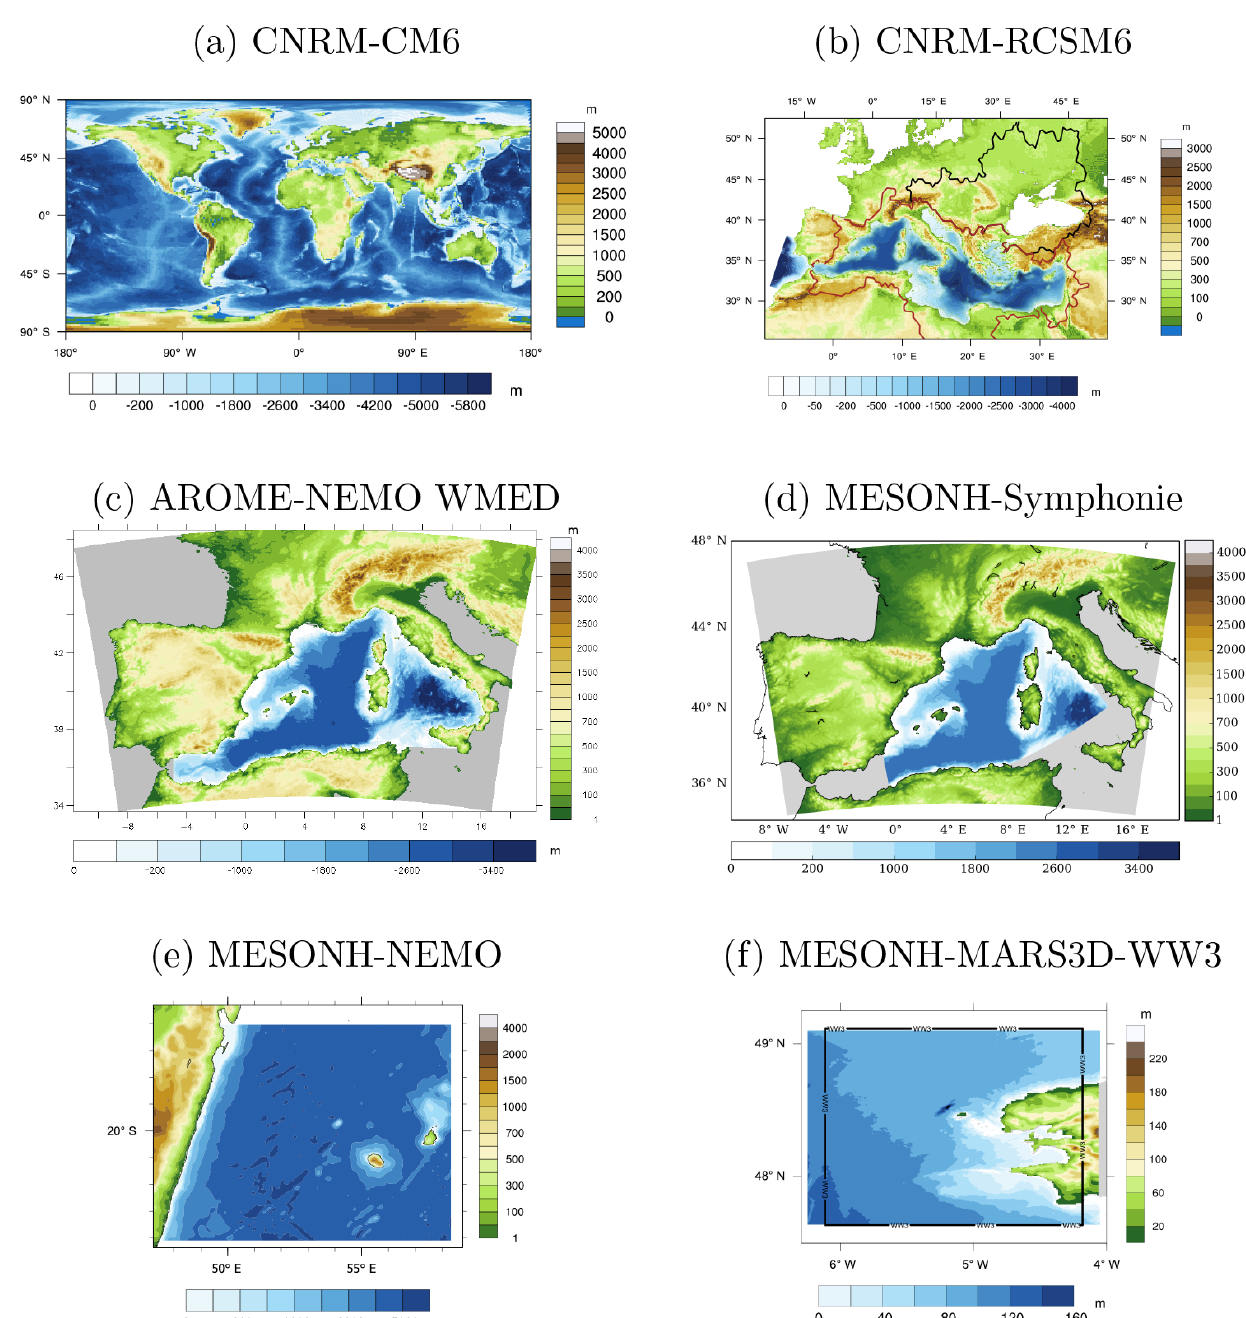
Figure 2. Domains of the coupled systems: topography (green colours) and bathymetry (blue colours) of the respective models (a) CNRM- CM6, (b) CNRM-RCSM6, (c) AROME-NEMO WMED, (d) MESONH-Symphonie over the western Mediterranean Sea, (e) MESONH- NEMO over the south-eastern Indian Ocean, and (f) MESONH-MARS3D-WAVEWATCH3